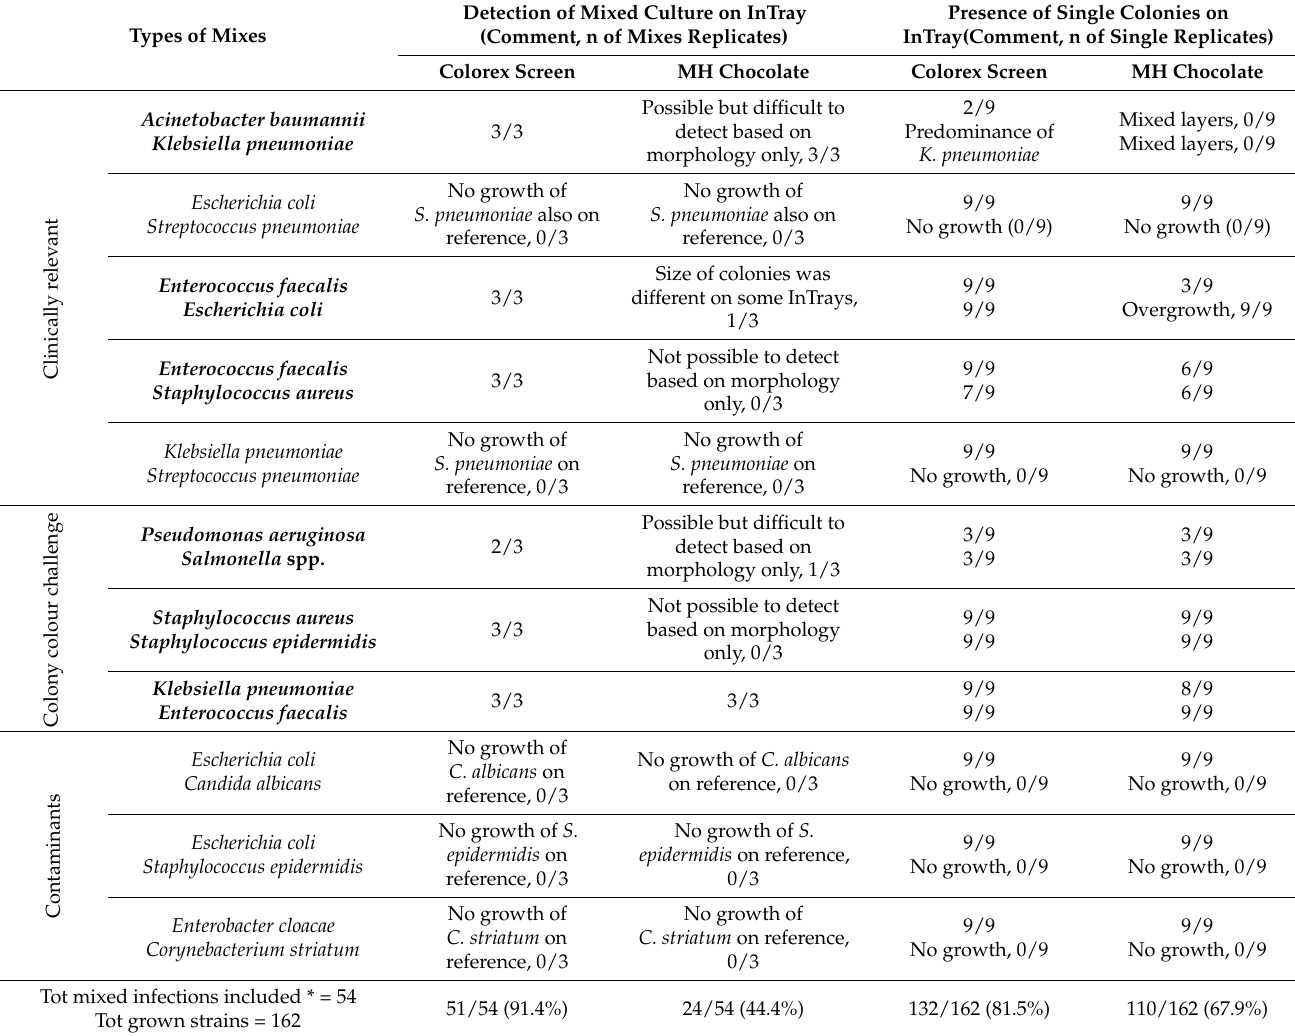
Table 6. Detection of mixed cultures and presence of single colonies on InTray MH chocolate and Colorex Screen media cassettes. * the total number of mixed cultures included only the number of replicates of mixes successfully recovered from the reference media (in bold in the